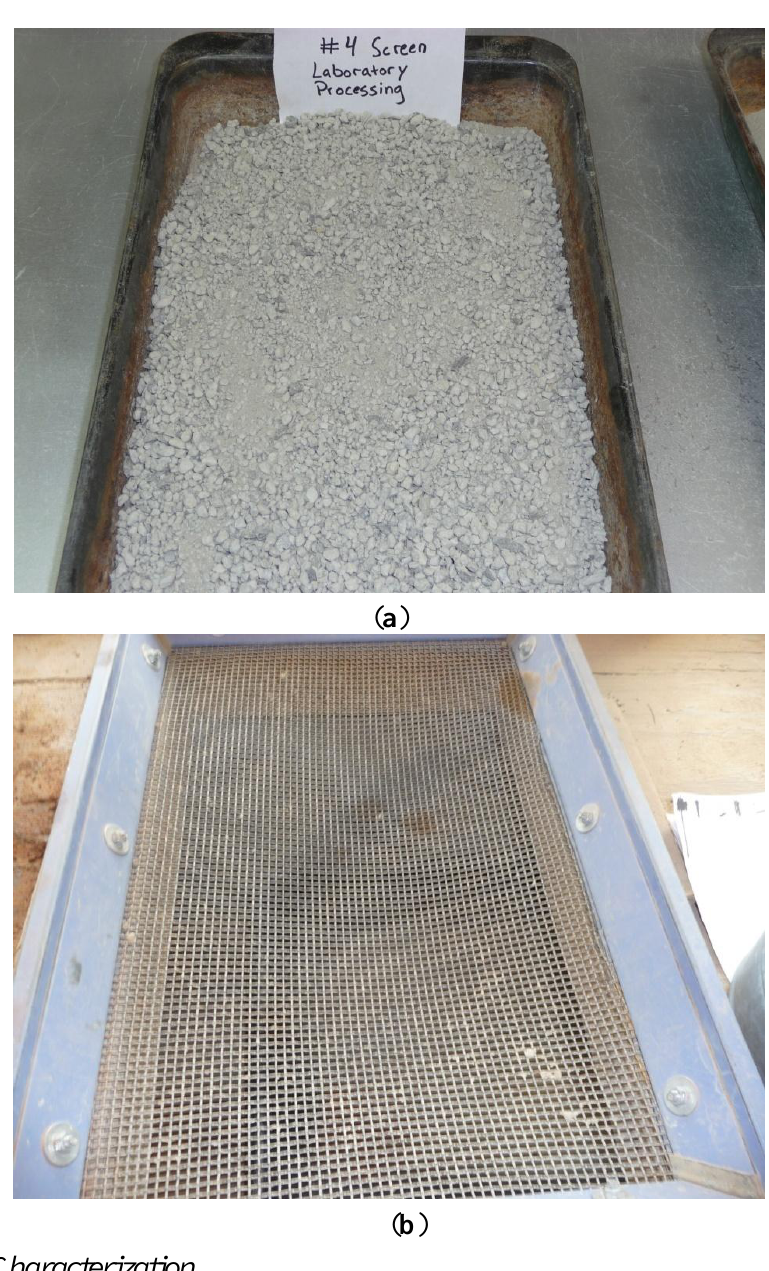
Figure 2. ( a ) A stockpile sample processed manually using #4 screen (SM) ( b ) #4 screen used in manual